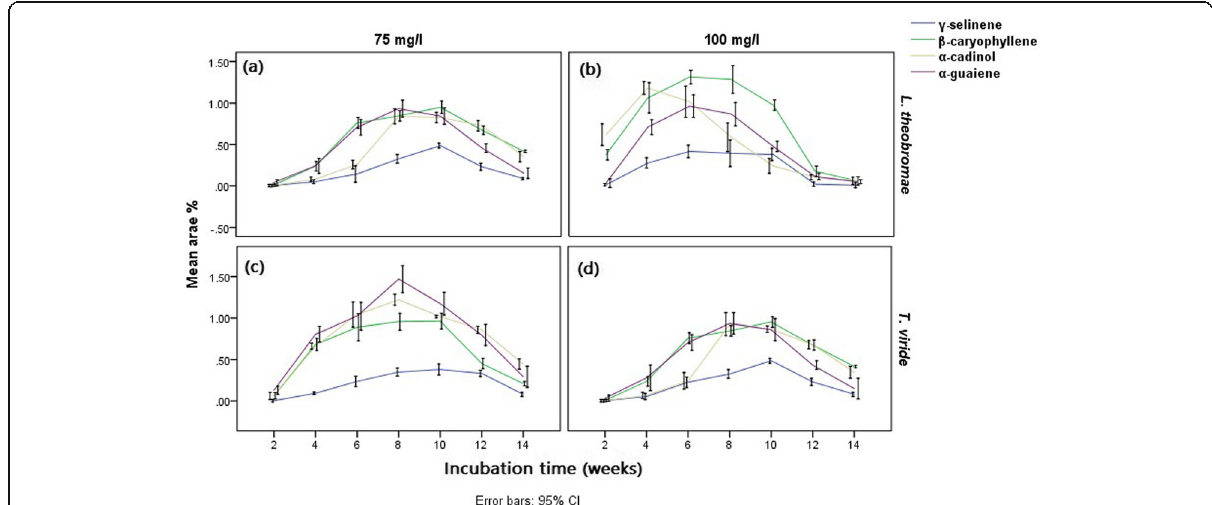
Fig. 10 Mean area percentages of sesquiterpenes produced in G. walla calli elicited with ( a ) 75 mg/l, ( b ) 100 mg/l L. theobromae and ( c ) 75 mg/l, ( d ) 100 mg/l T.